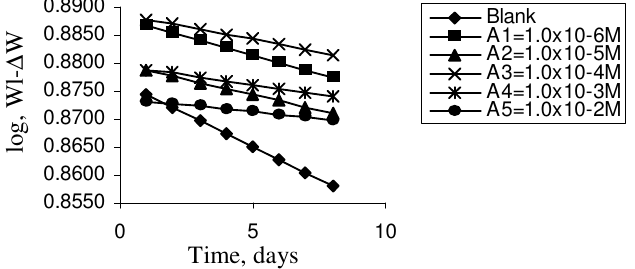
Figure 11. Variation of log (Wi - ∆ W) with time (days) for mild steel coupons in 2 M HCl solution containing 2-benzoylpyridine at 303K.